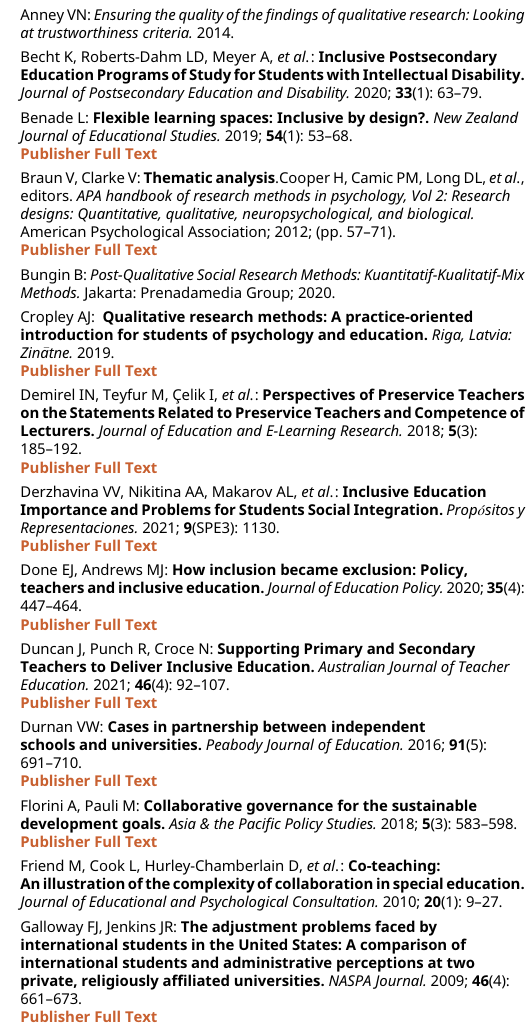
Figshare. Data of Questioner and Interview-Rasmitadila.docx. DOI: https://doi.org/10.6084/m9.figshare.16782553.v1 This project contains the following underlying data: - Dataset of Questioner and Interview from the